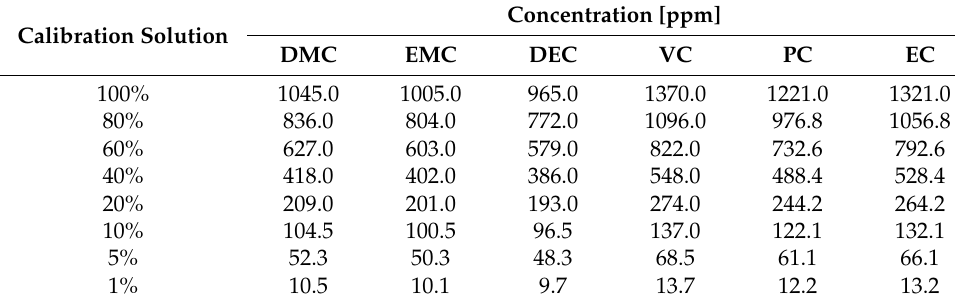
Table 2. Concentrations of carbonates in calibration